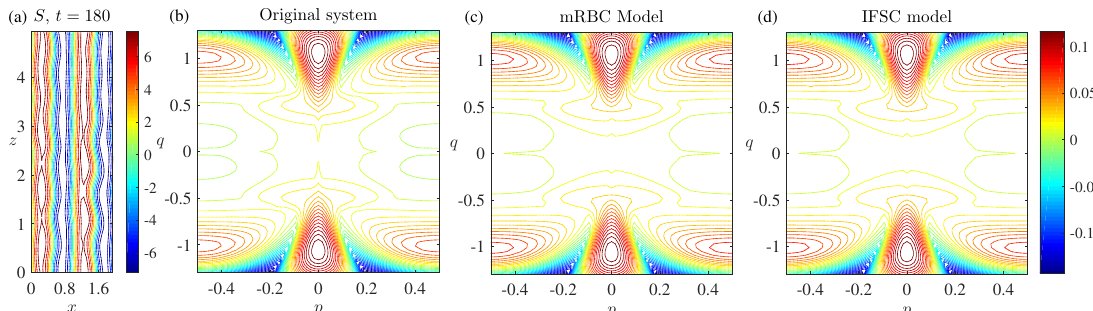
Figure 4. ( a ) The salinity field in the early stages ( t = 180) of the development of a secondary instability in a 2 (cid:96) opt × 5 (cid:96) opt domain when Ra = 1.1. Contours of constant growth rate α in the ( p , q ) plane for ( b